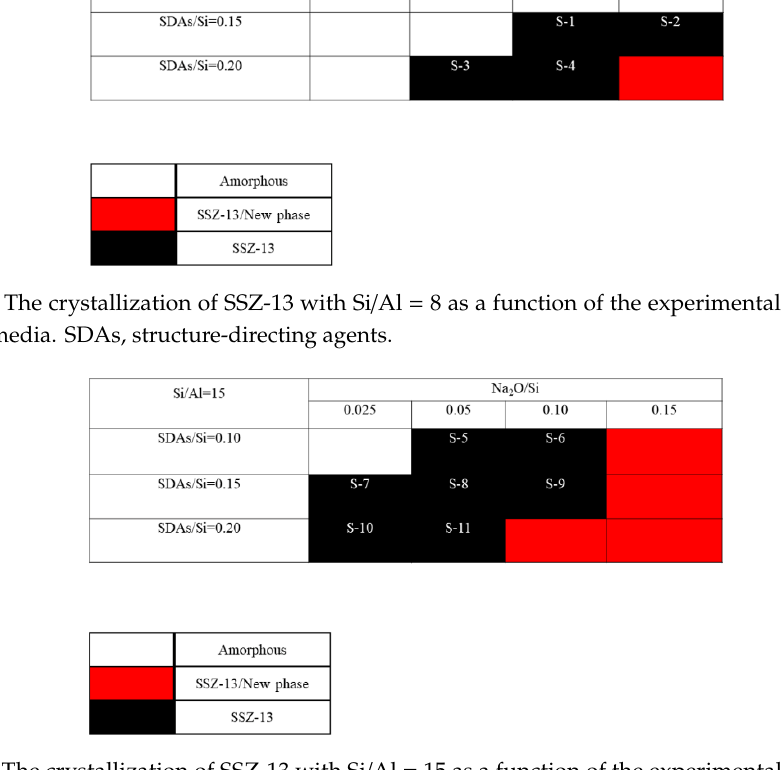
Figure 2. The crystallization of SSZ-13 with Si / Al = 15 as a function of the experimental variables in alkaline media.